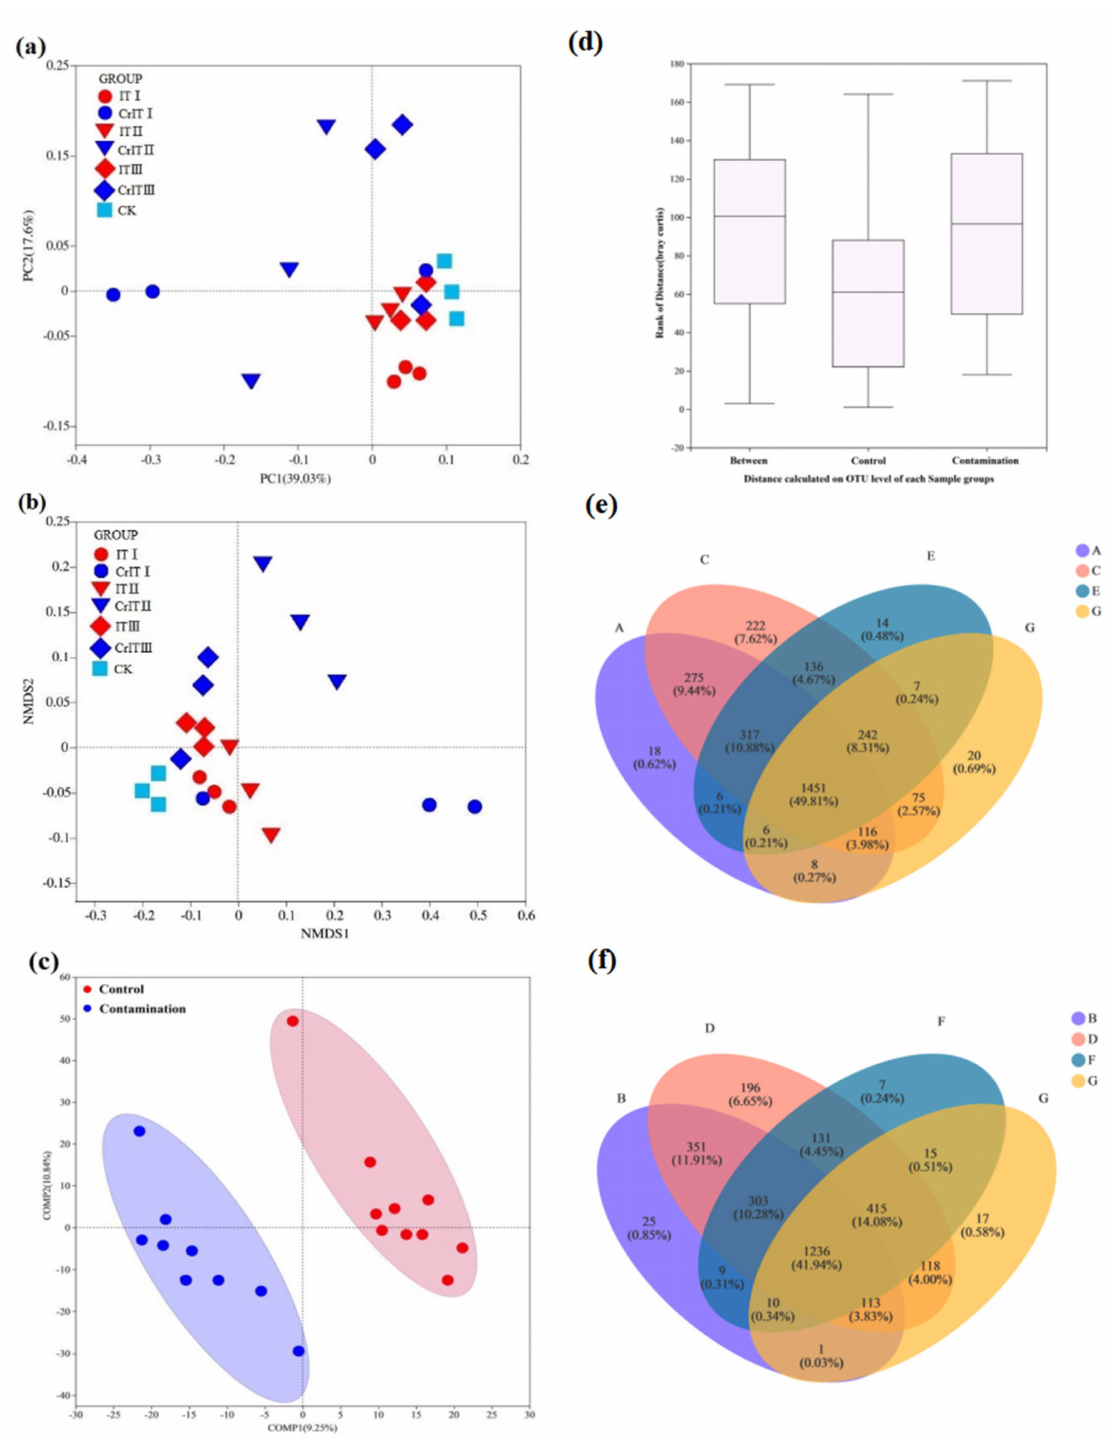
Figure 3. PCoA analysis on weighted UniFrac distance ( a ), NMDS analysis on Bray-Curtis distance ( b ), PLS-DA analysis ( c ). ANOSIM analysis (R = 0.1623, p < 0. 05) ( d ). The control contains treatments of ITI, ITII, and ITIII ( e ), and the Contamination contains treatments of CrITI, CrITII, and CrITIII. I and ( f ) are Venn diagrams of rhizosphere microbial communities in the control and pollution groups. Different colors represent different treatments. The overlapped part is the number of common species, while the non-overlapped part is the number of unique species. A, C, and E were the control group without Cr in I. tectorum single, double, and three plants, respectively. B, D, and F were polluted groups with I. tectorum single, double, and triple Cr treatments, respectively. G is for unplanted and bulk soil